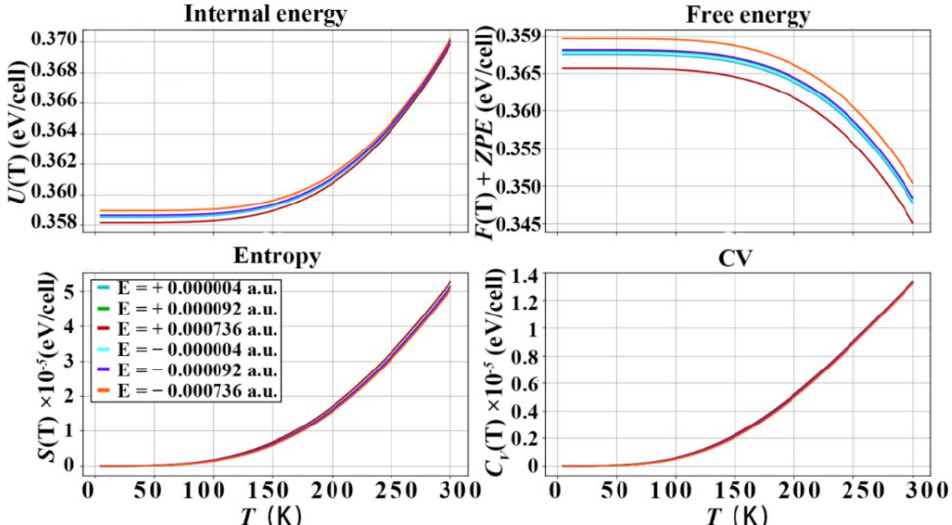
Figure 10. Thermodynamic properties of diamond, after applying different electric fields in the [110] crystallographic direction of diamond.